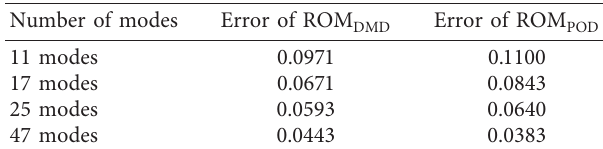
Figure 10: SPDMD reconstruction of the 200hPa jet flow field (11 SPDMD modes) at (a) T � 60h and (b) T � 124h (velocity visualized by vector plots and the background color contours visualize the vorticity component). Table 2: The average relative error of the POD/SPDMD reduced- order